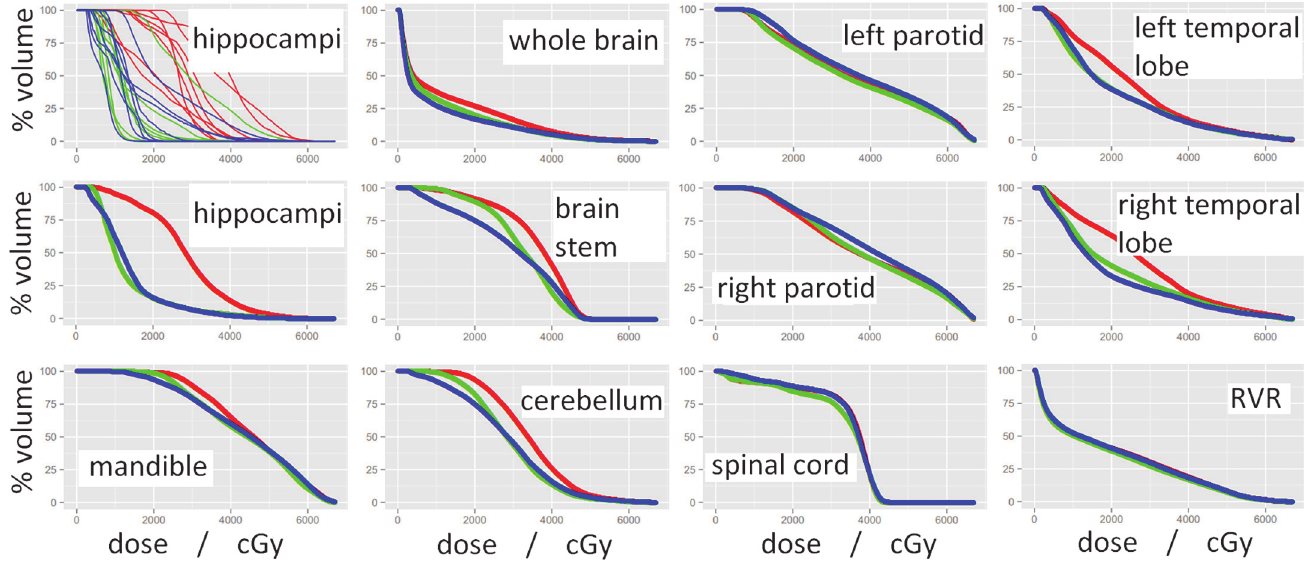
Fig 3. Dose-volume histograms (DVHs) for various OARs with red, green, and blue representing standard clinical, HSRT, and BSRT plans respectively. All curves shown are average DVHs for the 8 NPT cases that were re-planned using both HSRT and BSRT methods, except for the top-left panel, which shows the individual DVH curves for each